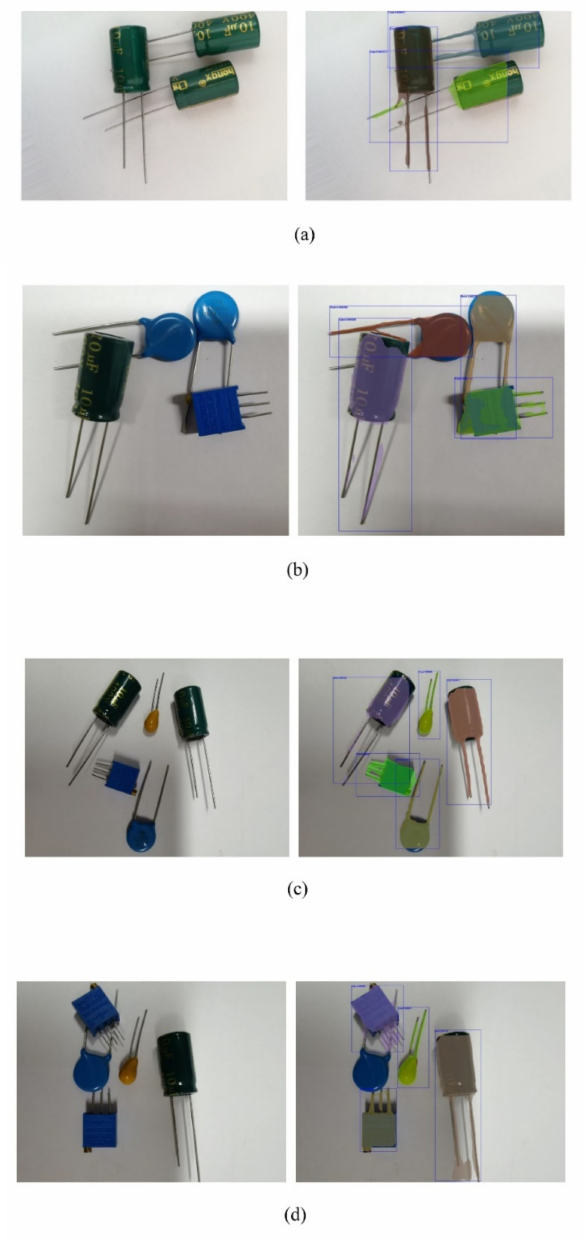
Figure 12. Electronic component segmentation under di ff erent light intensity; new testing images (left) and output of the improved Mask R-CNN (right). ( a , b ), detection of electronic components under intense light. ( c , d ), detection of electronic components under weak-light or shadow